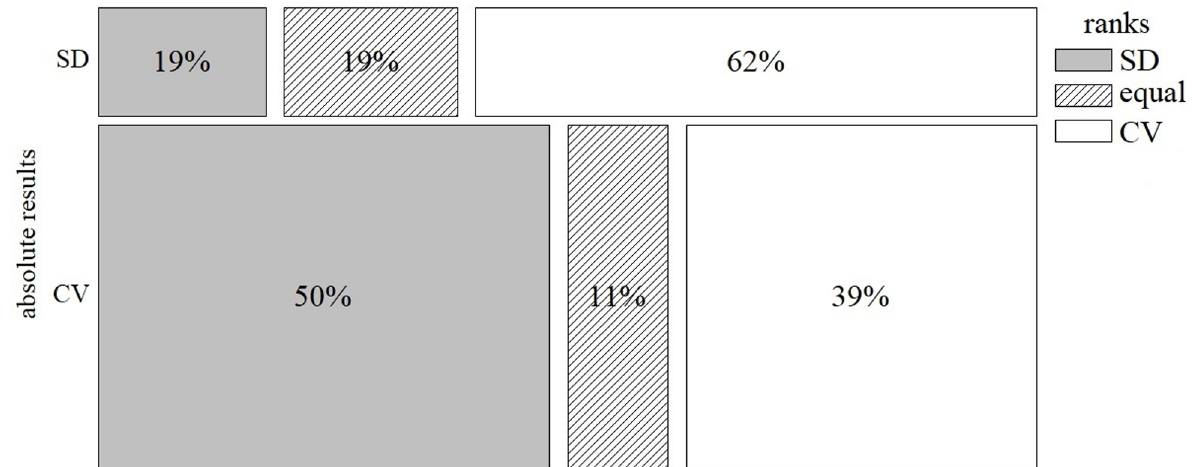
Fig 8. Structure of individual subjects on the basis of the results of the TOPSIS method (CV vs. SD).